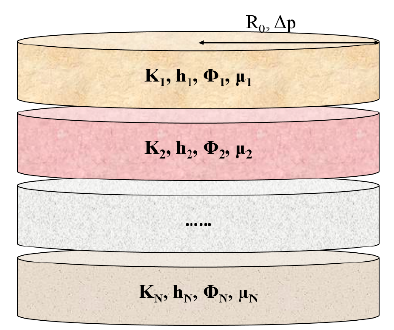
Figure 2. Schematic of planar radial multilayer water flood model.